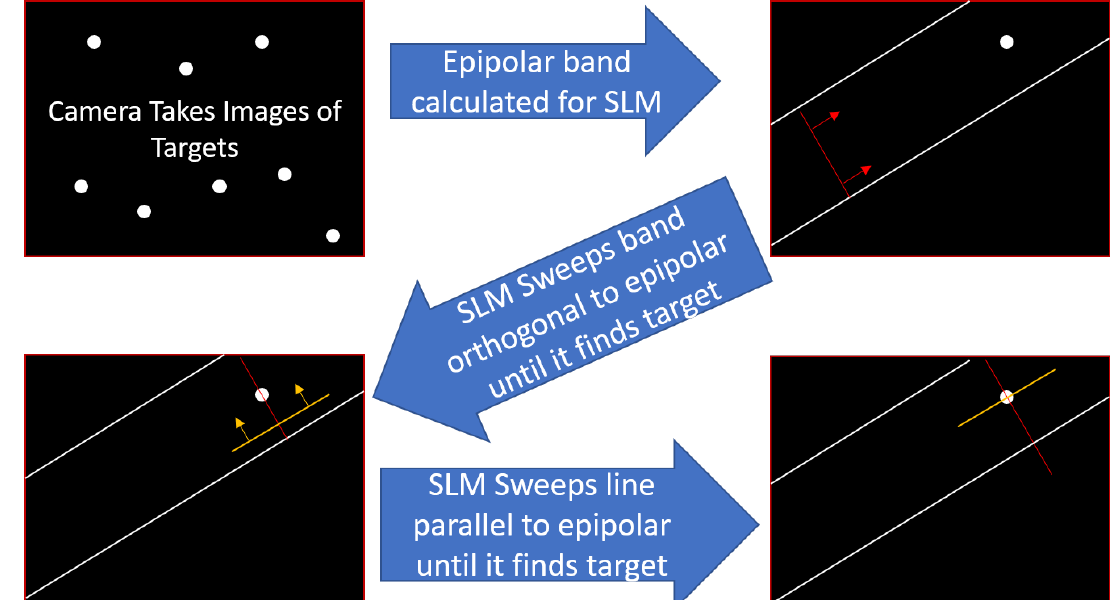
Figure 6. Epipolar searching algorithm for calculating SLM image coordinate for each